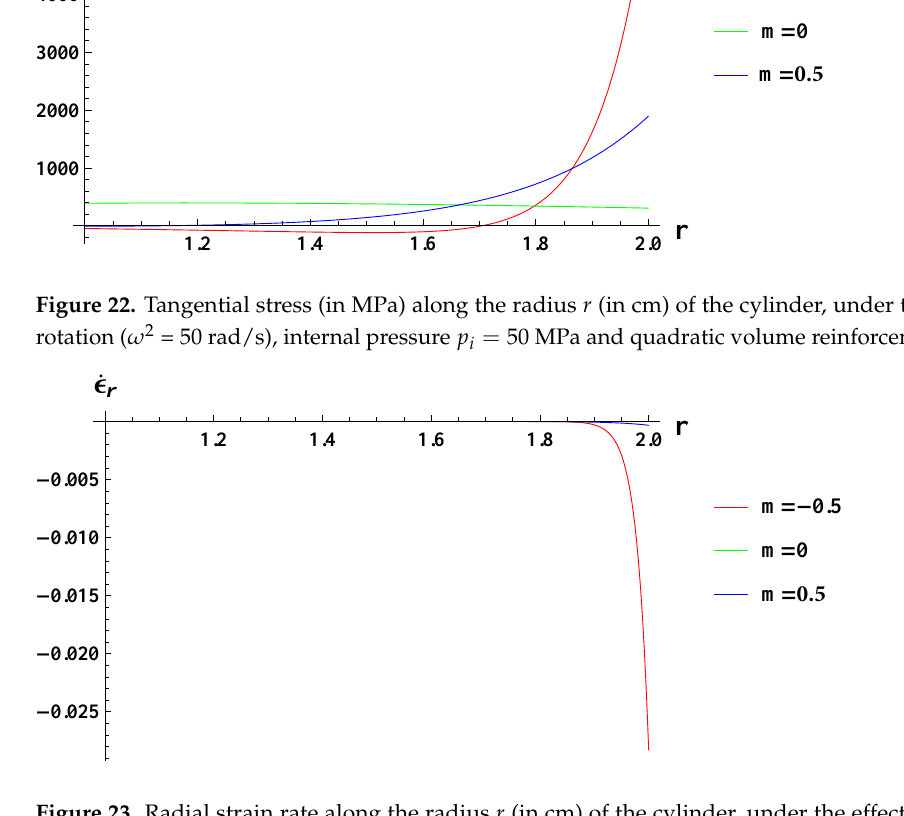
Figure 23. Radial strain rate along the radius r (in cm) of the cylinder, under the effect of rotation ( ω 2 = 50 rad/s), internal pressure p i = 50 MPa and quadratic volume reinforcement.